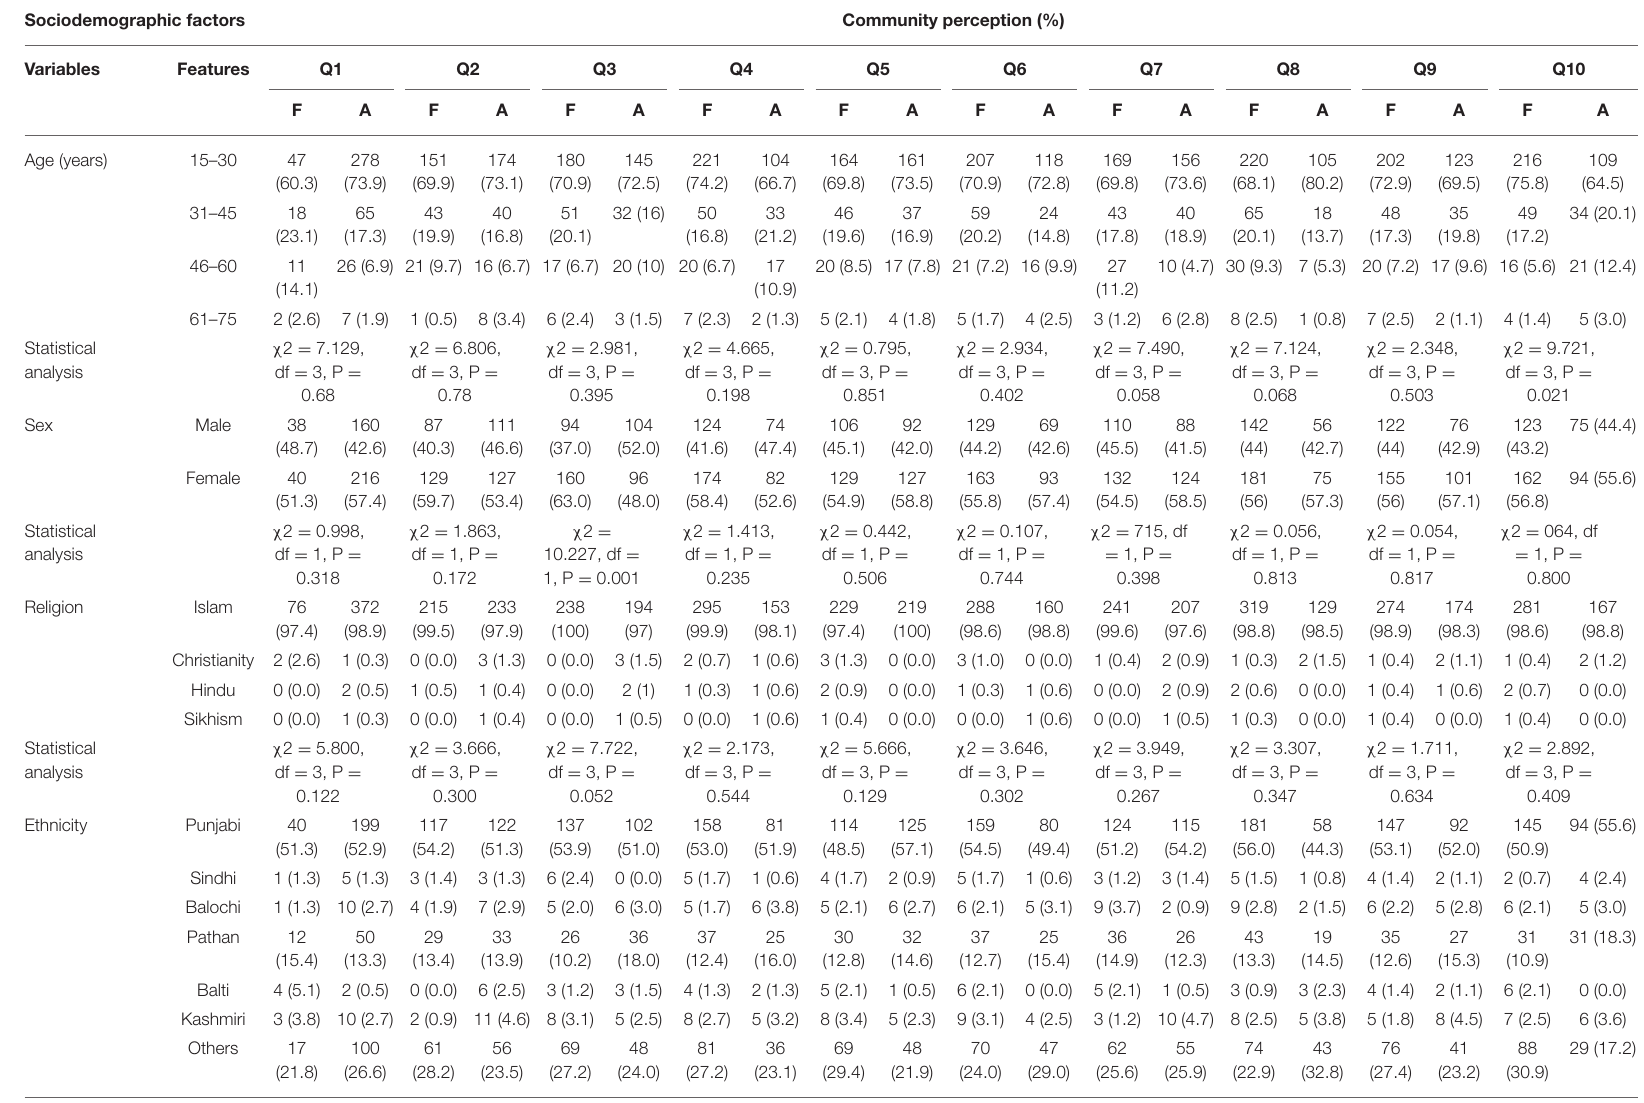
TABLE 8 | Presentation of Community perception across sociodemographic